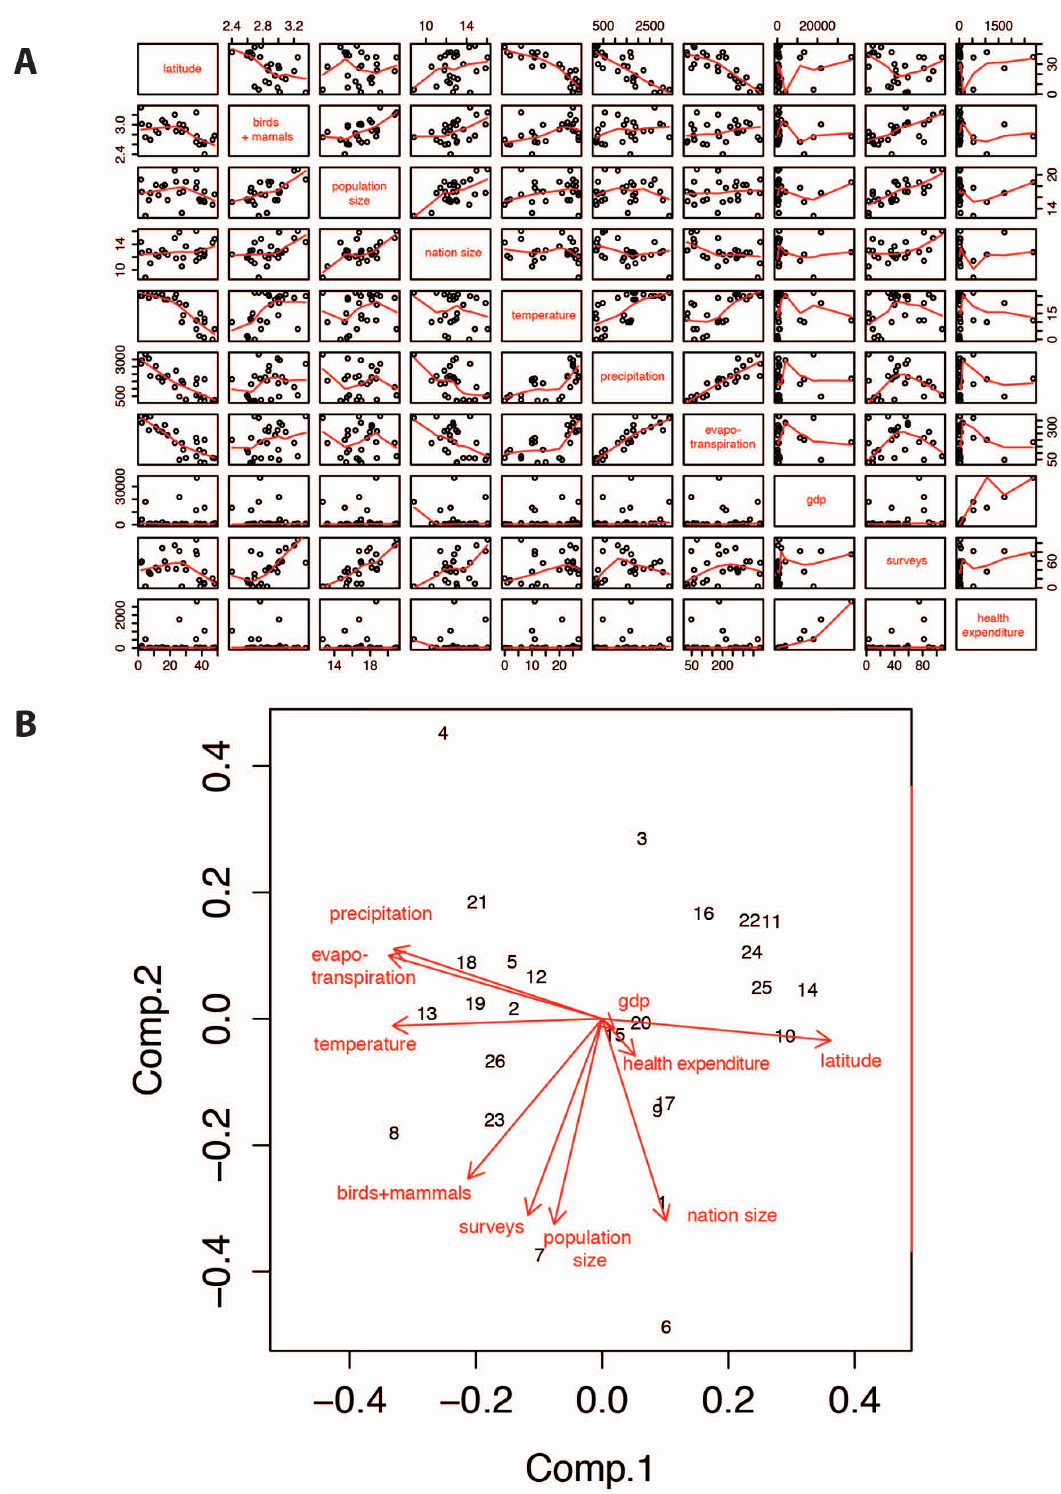
Figure 1. A. Correlation among geographic (latitude, evapotranspiration, nation area size), climate (mean temperature, mean precipitation), and socio-economic variables (population size, GPD per capita , health expenditure), and health surveys, potentially linked with the richness infectious diseases and their outbreaks (see raw data in File S1): B. Principal Component Analysis on geographic (latitude, evapotranspiration, nation area size), biodiversity (bird and mammal richness, forest cover, vertebrate species at threat), climate (mean temperature, mean precipitation), and socio- economic variables (population size, GPD per capita , health expenditure), and health surveys, potentially linked with the richness infectious diseases. Distributions of variables were normalized using log-transformation or asin-square root transformation (see raw data in File S1).